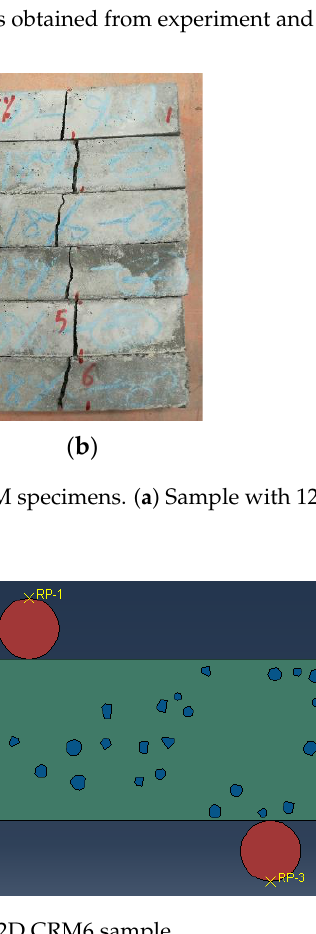
Figure 21. Comparison of results obtained from experiment and mesoscale simulation.